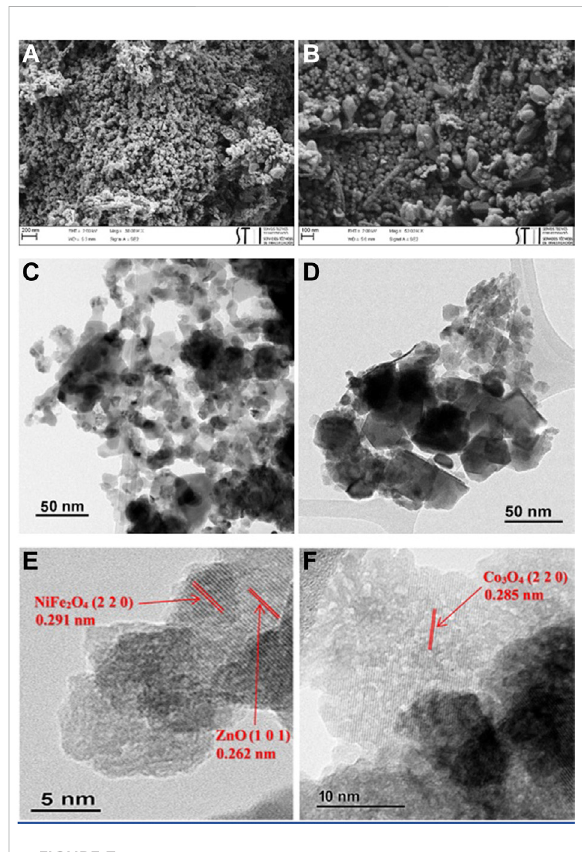
FIGURE 7 (A,B) FESEM of ZnO/NiFe 2 O 4 /Co 3 O 4 , (C,D) TEM of ZnO/ NiFe 2 O 4 /Co 3 O 4 , and ( E,F ) HRTEM of ZnO/NiFe 2 O 4 /Co 3 O 4 .